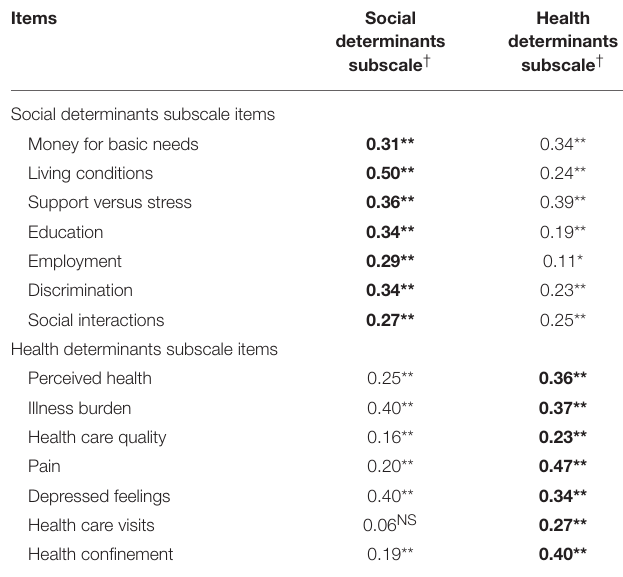
TABLE 3 | Convergent validity of item selection for the Duke-PH scale. Items